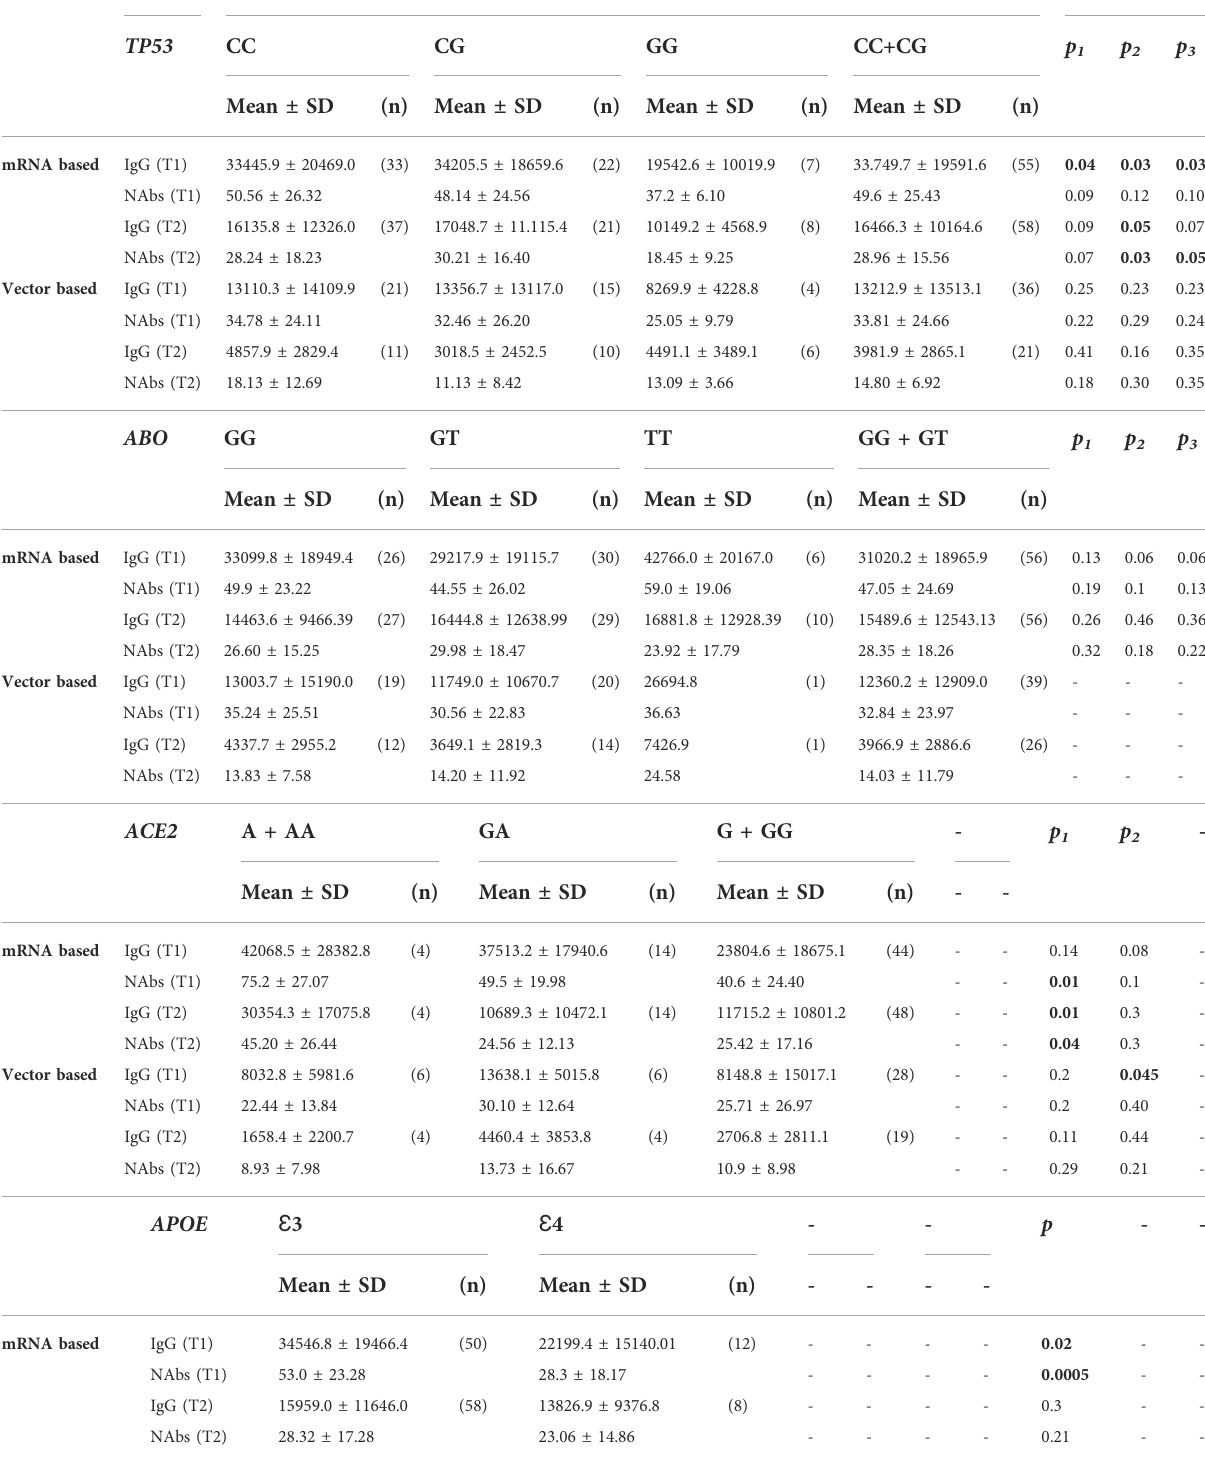
TABLE 4 IgG and NAbs levels strati fi ed by vaccine formulation and by